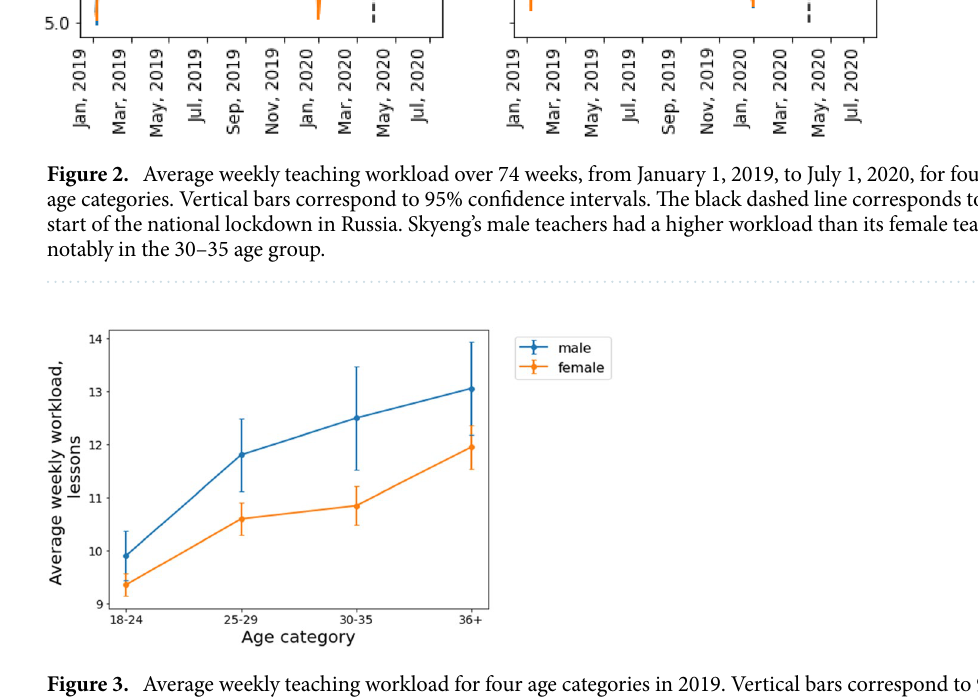
Figure 3. Average weekly teaching workload for four age categories in 2019. Vertical bars correspond to 95% confidence intervals. Skyeng’s male teachers had a statistically significant higher workload than female teachers in each of the age